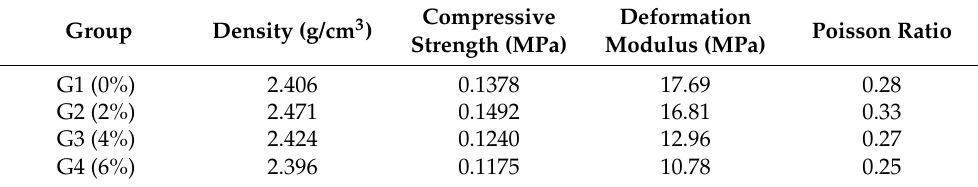
Table 4 Physical and mechanical indicators of similar materials: Table 4. Physical and mechanical indexes of similar materials with different VEA dosage. Group Density (g/cm 3 )